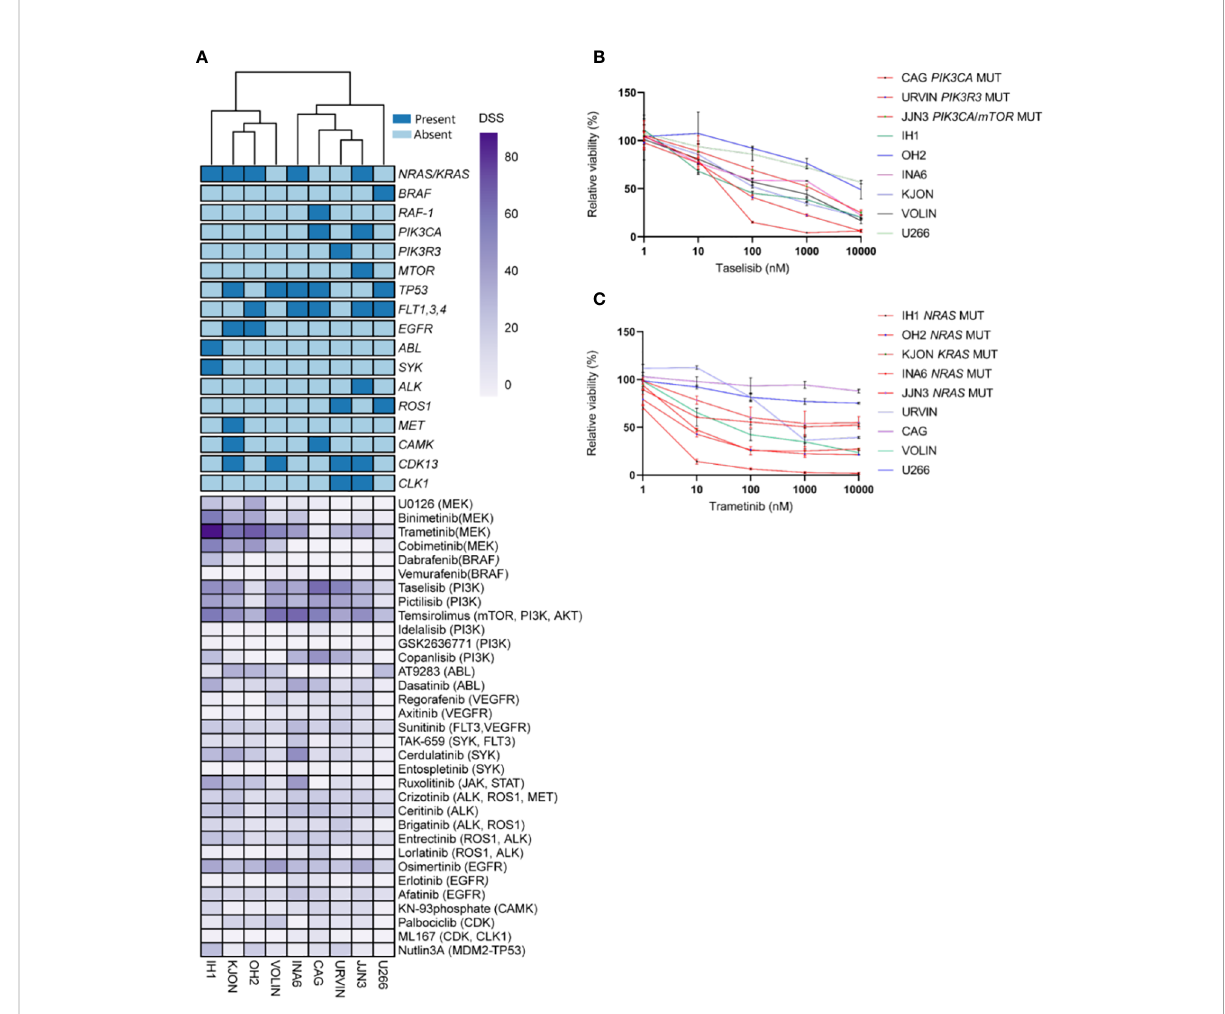
FIGURE 1 Targeting point mutations in cancer-driving genes in MM cell line models. A – C, Freshly thawed cells from the indicated MM cell lines were dispensed in 384-well plates pre-coated with a customized drug library of 33 single drugs. At 72h, cell viability was assessed by CellTiter-Glo. A drug sensitivity score (DSS) was calculated ranging from 0 to 100 for the entire drug library (see Materials and Methods). High DSS indicates high drug sensitivity. (A) , MM cell lines (n=9) were exposed to single drugs as described above. DSS (rows) was calculated for each drug and cell line and plotted as a heatmap. Columns are clustered using Euclidean distance and the Ward linkage method. Column annotations (top) indicate mutated genes, where blue means mutation present, while light blue absent. (B, C) , Concentration-response curves for the effects of taselisib and trametinib, on the viability of indicated MM cell lines (72h) treated as above. Graphs show mean viability ± standard deviation (SD, n=3). MM cell lines with mutations in PI3K / mTOR and RAS target genes are indicated in red, whereas the MM cell lines in different colored lines are wild- type and each line indicates cell viability effects in each individual cell